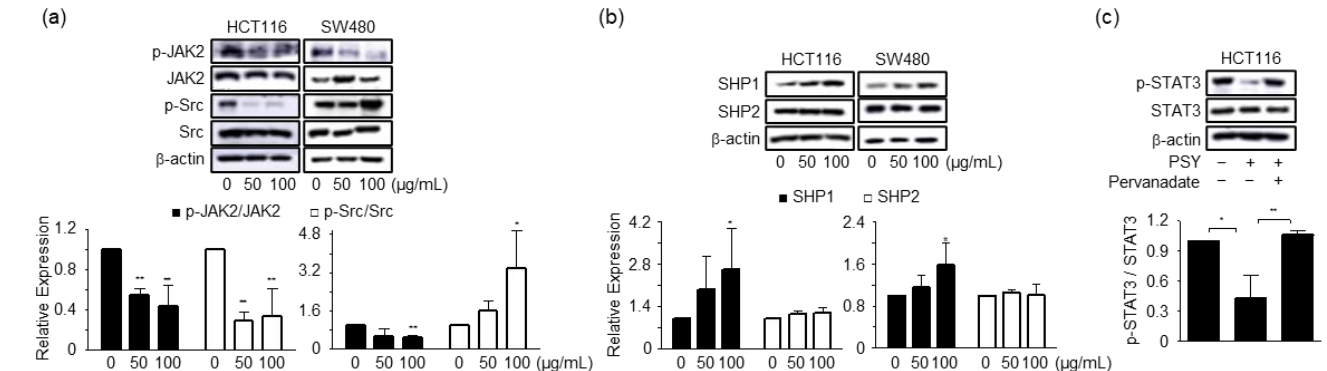
Figure 5 . Effects of PSY on the STAT3 signaling pathway in human CRC cells. Whole lysates of CRC cells treated with PSY EtOH-Ex for 24 h were subjected to Western blot analysis for JAK2, p-JAK2, Src, and p-Src ( a ), and SHP1 and SHP2 ( b ). In addition, lysates of HCT116 cells treated with pervanadate (5 µM) and PSY (50 µg/mL) for 24 h were subjected to Western blot analysis for STAT3 and p-STAT3 ( c ). β -actin was used as an internal control. Data in graphs present the mean ± SD to that of the untreated cells taken as 1 (*, p < 0.05 and **, p < 0.01 versus control).